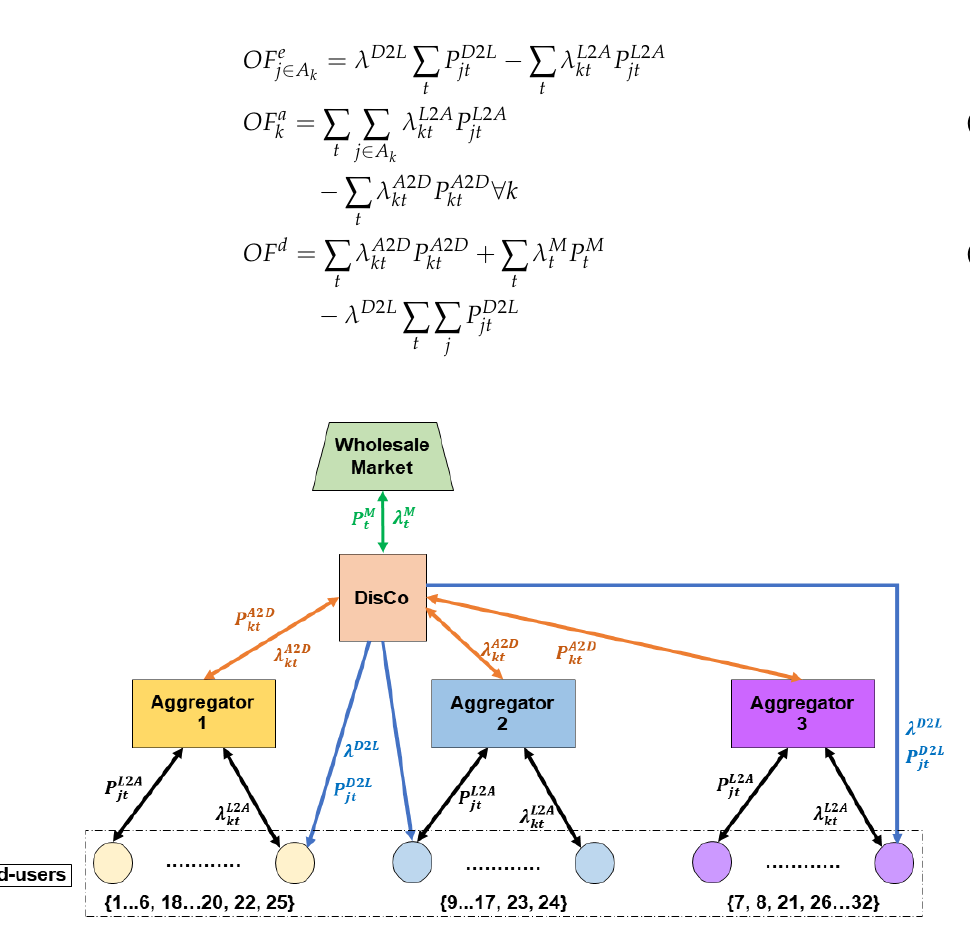
Figure 4. Agents and energy trading framework for the distribution network adapted with permission from